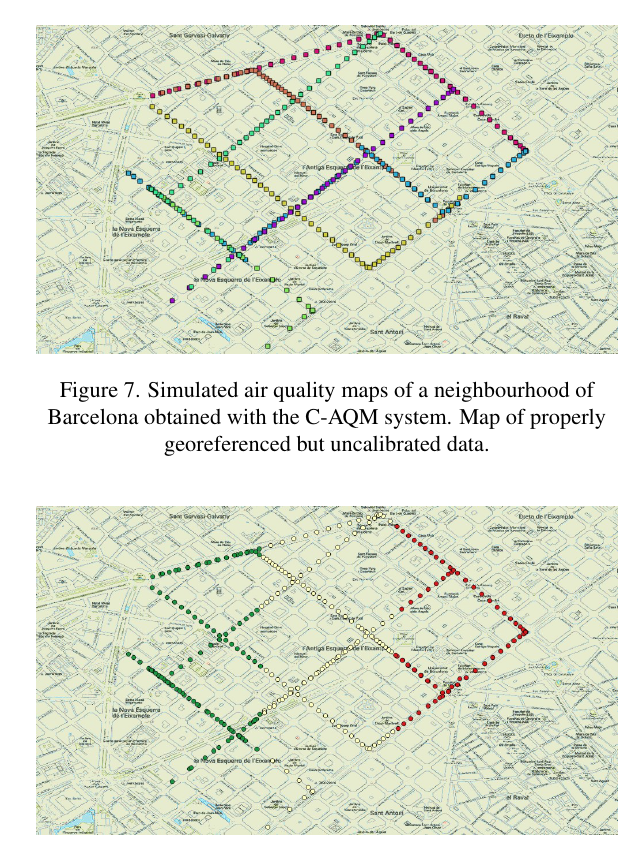
Figure 8. Simulated air quality maps of a neighbourhood of Barcelona obtained with the C-AQM system. Categorized map of properly georeferenced and calibrated data generated using